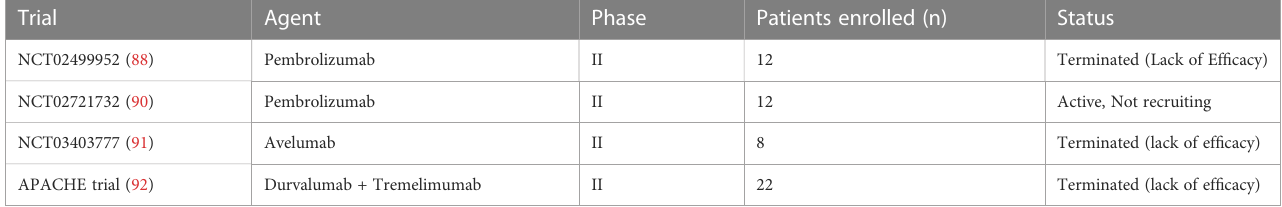
TABLE 1 Trials presenting anti-PD-1 inhibitor in GCTs.